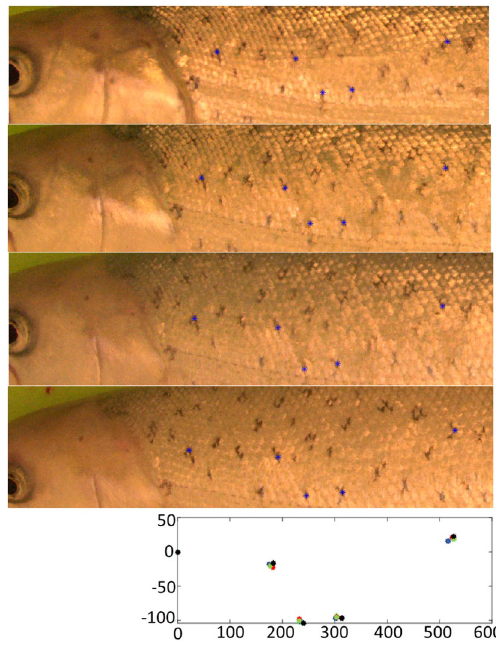
Figure 11. Manual localization of dots for one fish for four sessions, SL1–SL4. Blue dots were manually localized. Bottom plot shows aligned dots from SL1–SL4. Manually localized dots were used for analysis of pattern